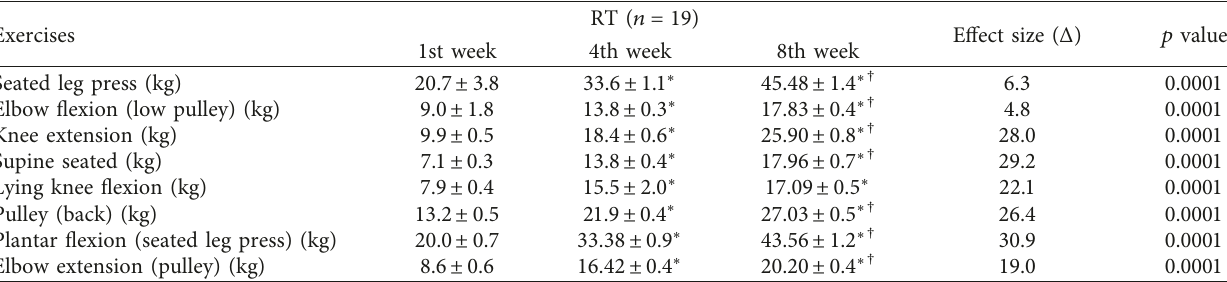
Table 3: Evolution of training load in first, fourth, and 8th weeks of RT.